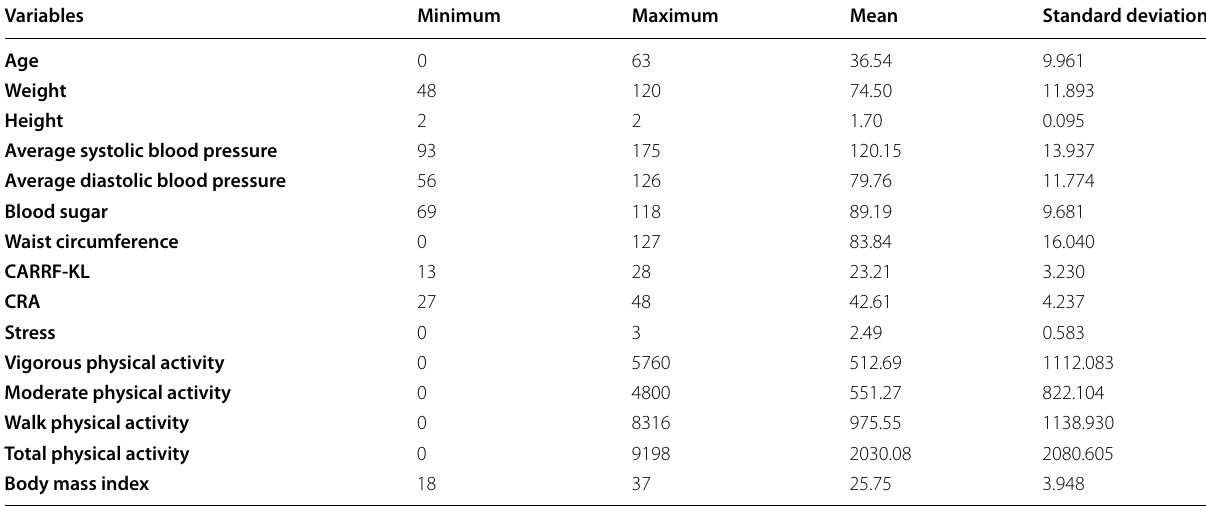
KEY: CARRF-KL Cardiovascular Risk Factor Knowledge Level, CRA Cardiovascular risk assessment